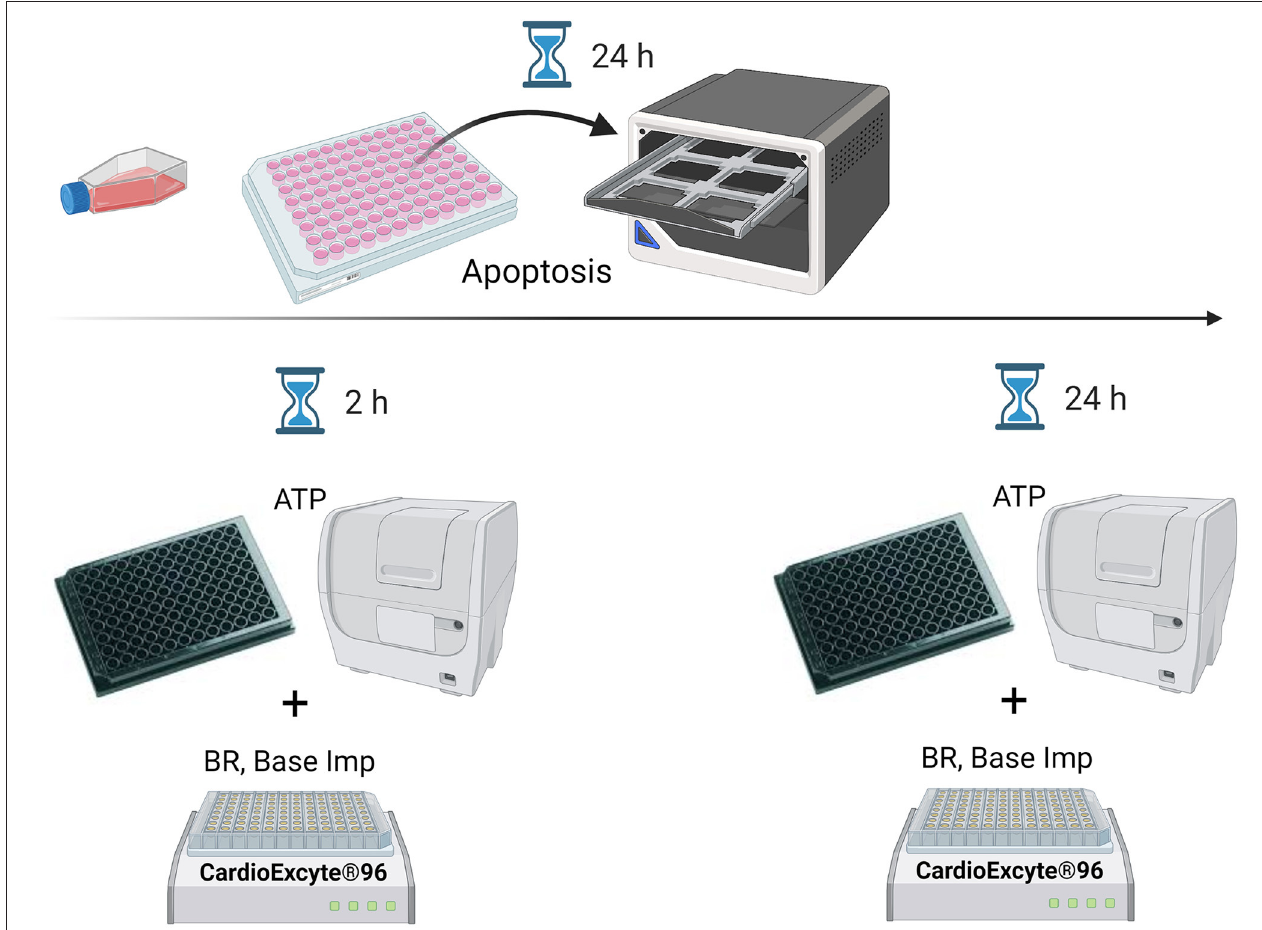
FIGURE 1 | Scheme of assay-specific measurement time points. The ATP and CE96 measurements were conducted 2 and 24h after the compound treatment whereas apoptosis was continuously monitored over 24h. BR, beating rate; Base Imp, base